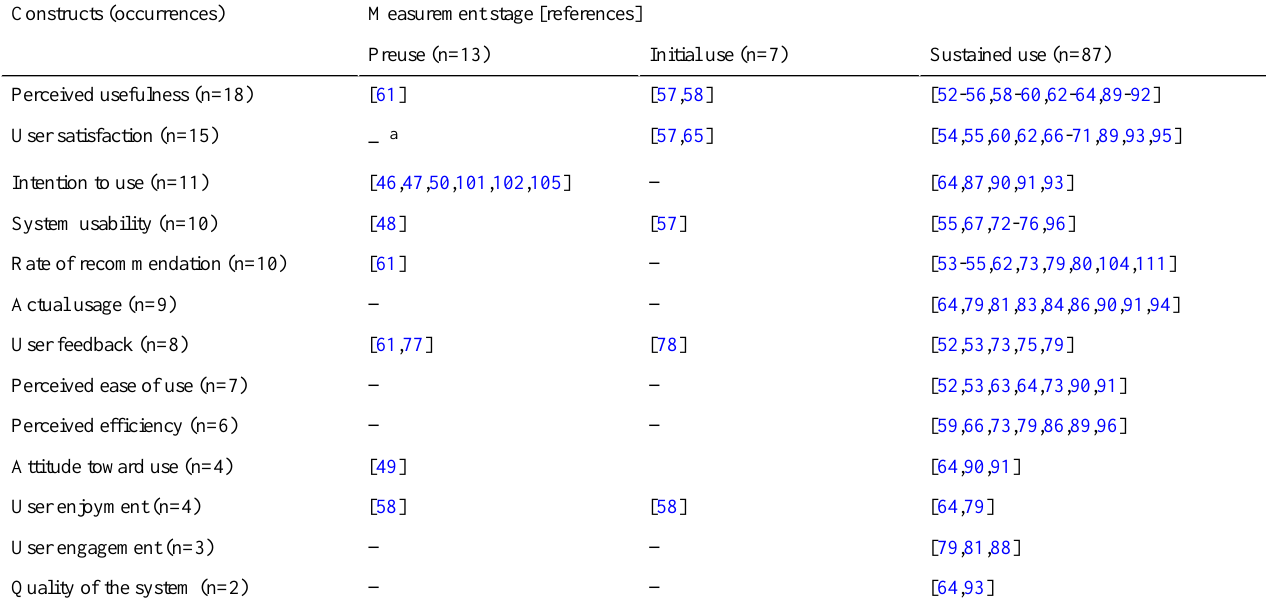
Table 4. Measurement timeline of constructs (some studies measured several constructs).